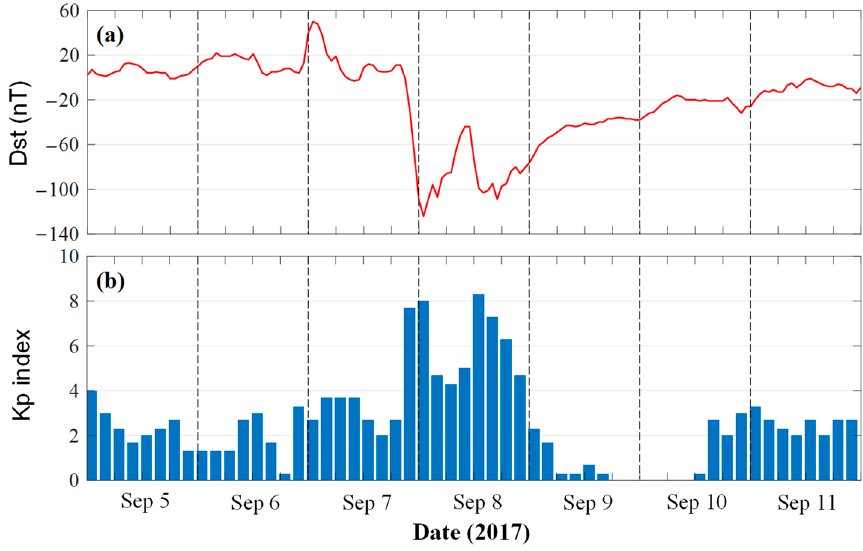
Figure 2. Geomagnetic indices observed from 5 to 11 September 2017. ( a ) Dst, ( b) Kp.